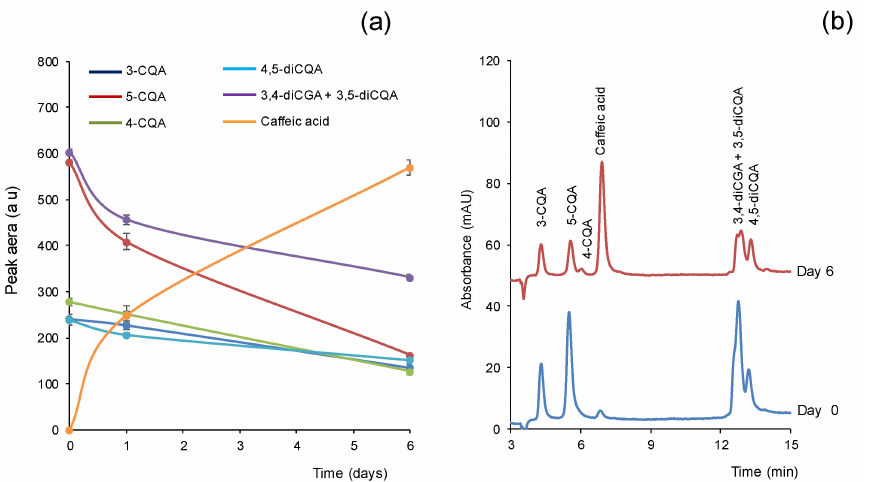
Figure 2. ( a ) Variation in the peak areas of CGAs in a solution freshly prepared and after storage. Concentration of the analytes, 0.5 µ g mL − 1 each; storage conditions, 4 ◦ C in the dark. ( b ) Chro- matograms obtained at 330 nm with the benchtop nanoLC system for a solution of CGAs freshly prepared and the same solution after storage for 6 days. For other details, see